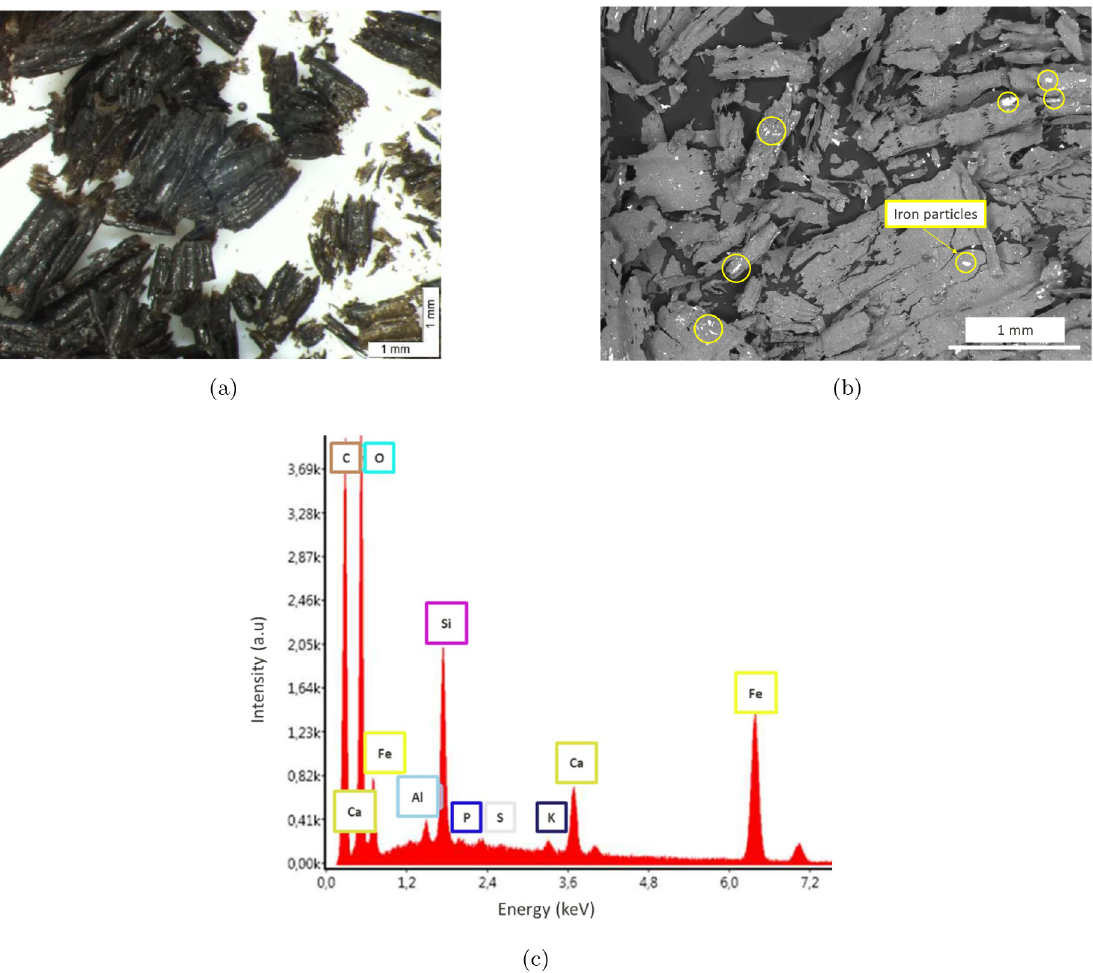
Fig. 20. (a) Third-body sample taken from the field after a wheel-slip event (slip rate > 1 % , optical image). (b) SEM (BSE detector, 20 kV) of the sample, (c) SEM–EDS spectrum characteristic of the sample, highlighting mineral/organic amalgam (presence of carbon, silica, and iron